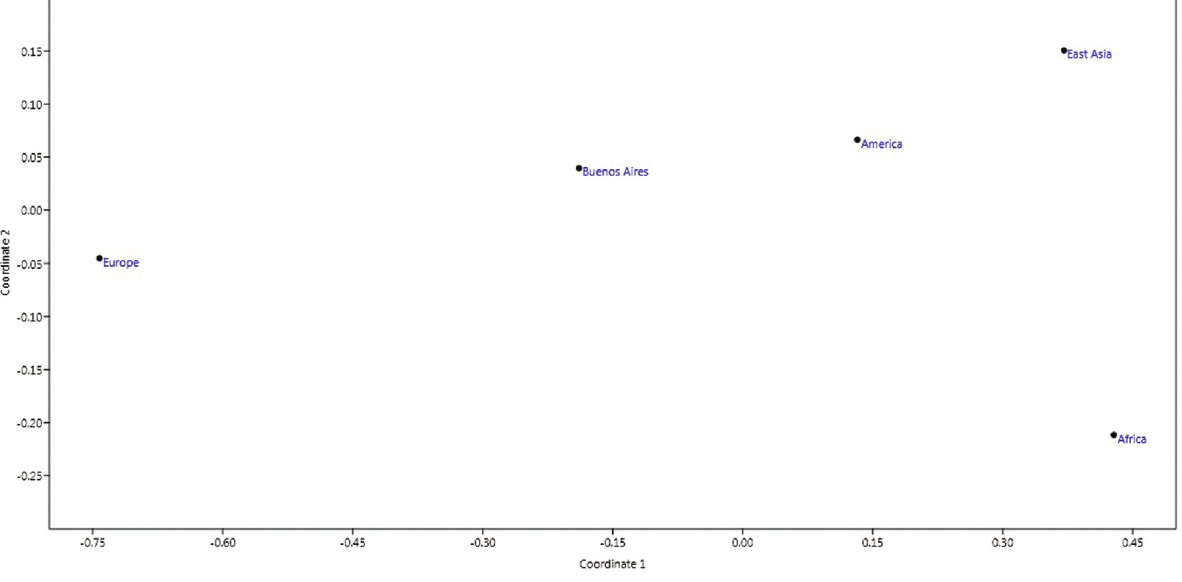
Figure 3 - MDS matrix performed with Past. The distance among populations is calculated from Fst. Stress